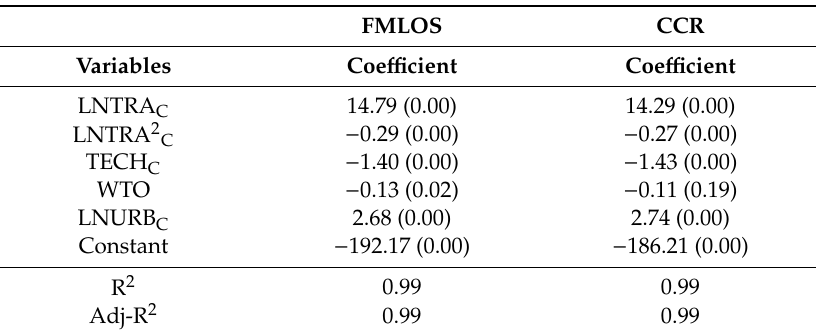
Table 11. Robustness analysis for Model 1.